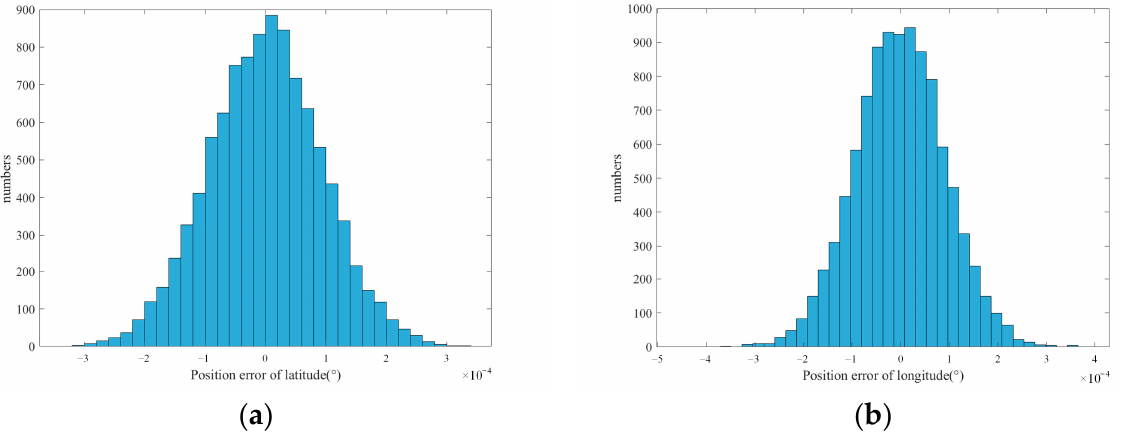
Figure 10. Probability distribution of longitude and latitude error. ( a ) Latitude error distribution; ( b ) longitude error distribution.